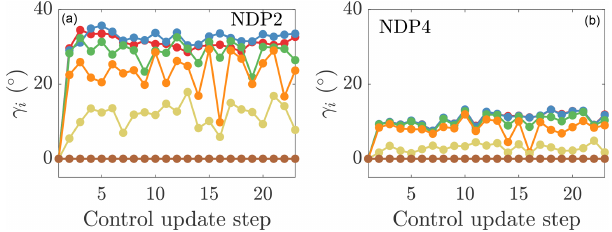
Figure 19. Time-averaged power production for the first and sec- ond wind turbines in the wind farm as a function of the control up- date steps for online control using the initial parameters to initialize the next state and (a) ˆ P p = 2 (NDP2) and (b) ˆ P p = 4 (NDP4). The LES power production is given by P , and the wake model state es- timation is given by ˆ P .